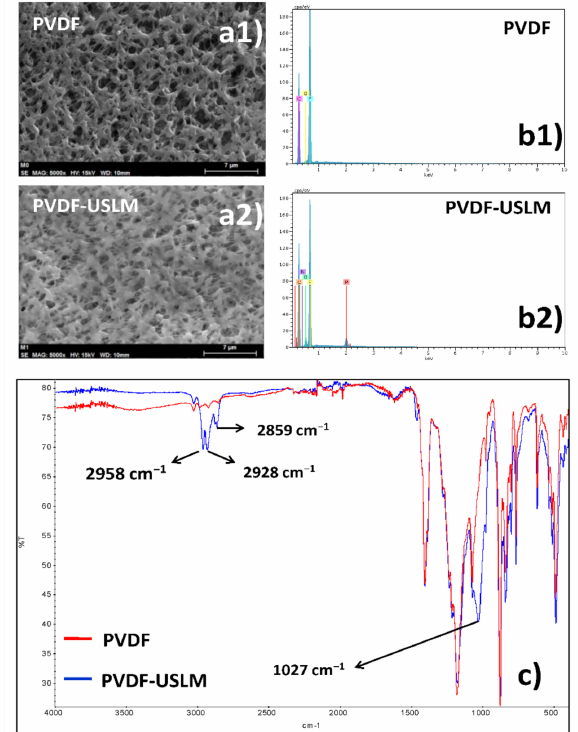
Figure 3. Membrane characterization of PVDF and PVDF-USLM by ( a1 , a2 ) SEM; ( b1 , b2 ) EDX; ( c )